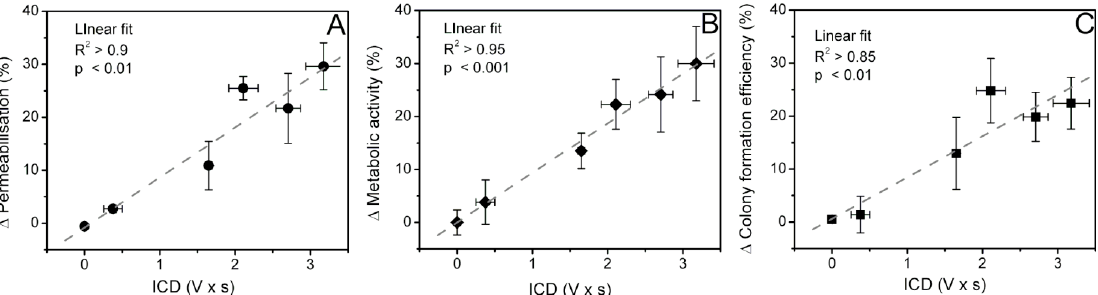
Figure 12. The correlation of ICD and the change ( Δ ) in cell permeabilization ( A ), cell metabolic activity ( B ), and cell colony formation efficiency ( C ).